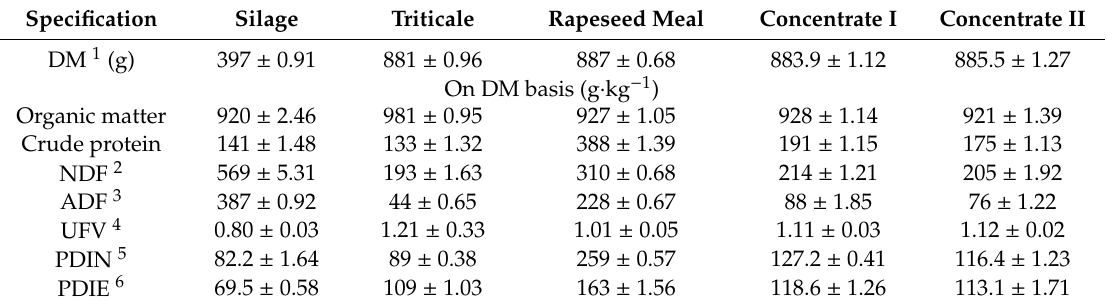
Table 1. Chemical composition and nutritional value of diets (mean ± standard error of the mean).